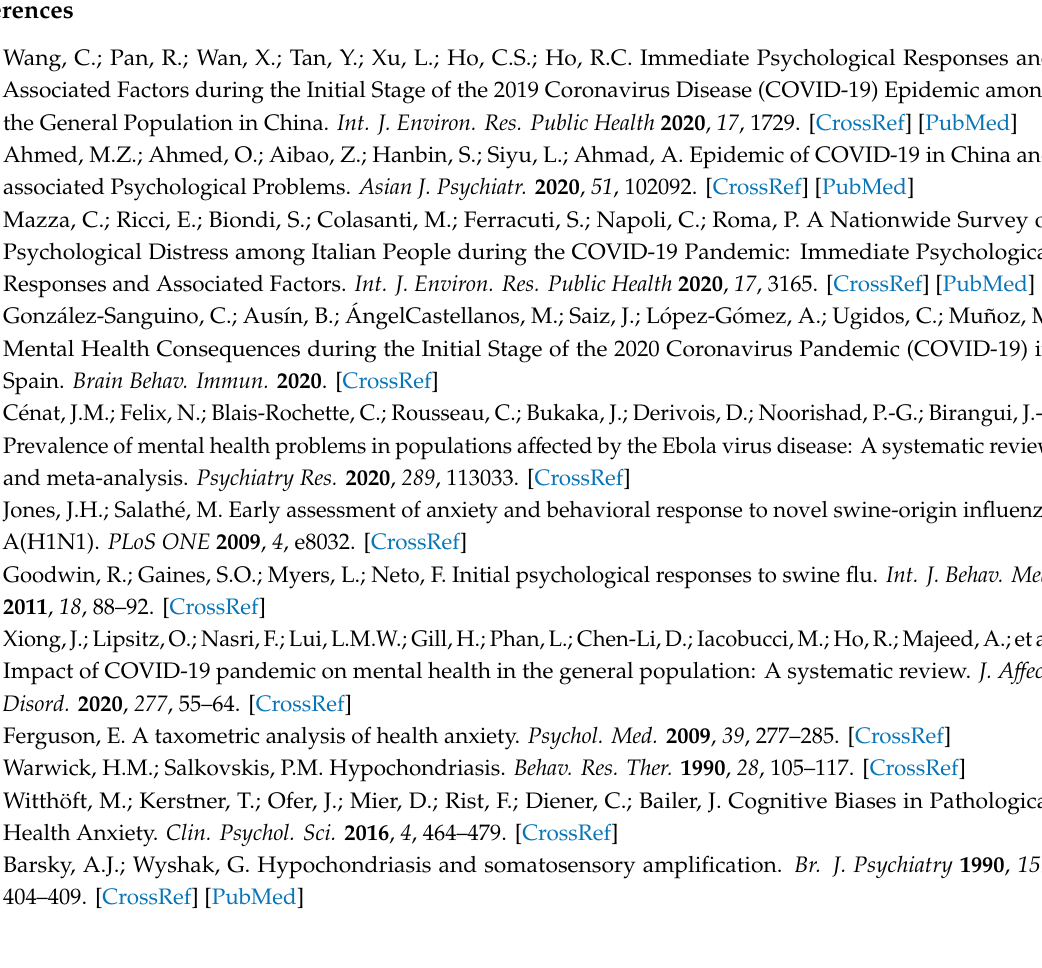
Table S1: Results of the correlational analyses on age (1), sex (2), education (3), profession (4; students vs. others), physical disease (6), immunosuppressive medication (7), mental disorder (8), health anxiety (SHAI) pre (9) and during COVID-19 (10), reassurance, avoidance and preventive behavior during COVID-19 (11–16), and anxiety in relation to SARS-CoV-2 (17–20) and to other diseases (21–23). Author Contributions: Conceptualization, K.S.S., S.M.J., and M.W.; methodology, K.S.S., S.M.J., and